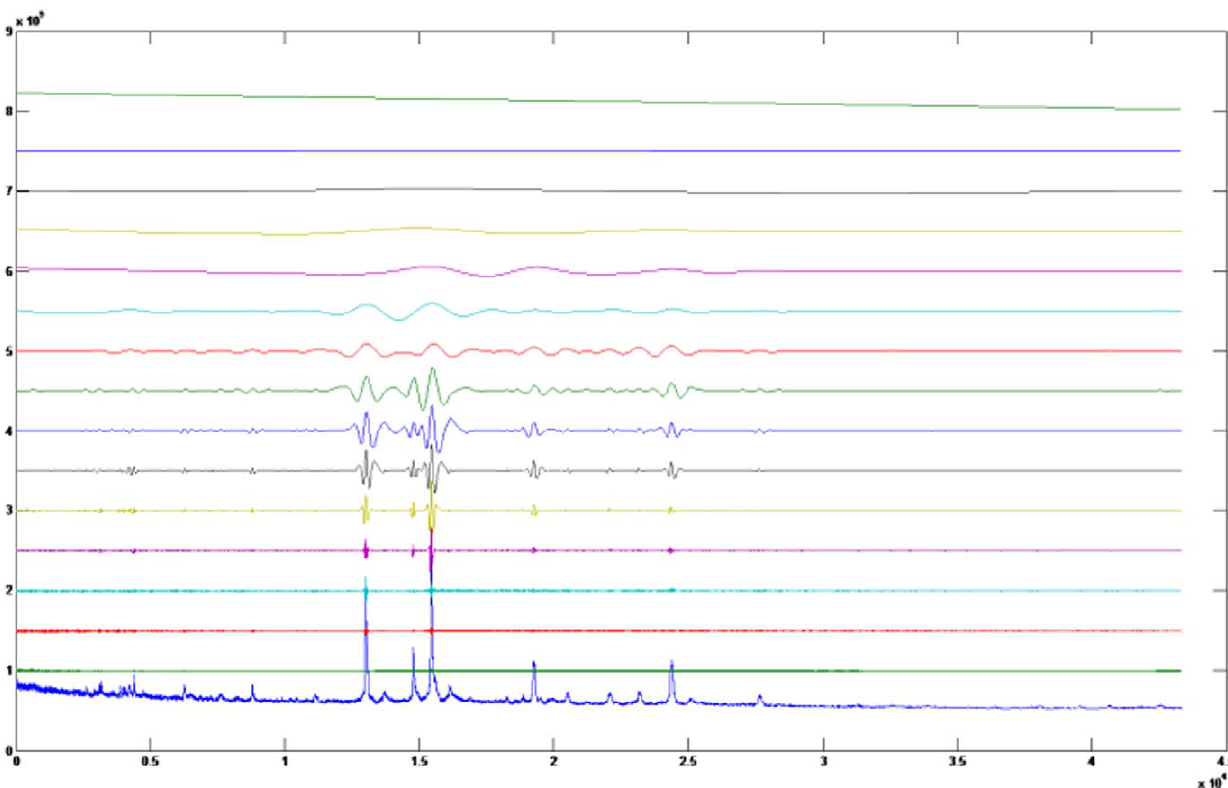
Figure 1. Components decomposed using HHT. HHT decomposes the spectrum into sixteen components. From bottom to top, we call them as C1, C2, and so on. Summation of all components can is the original spectrum.